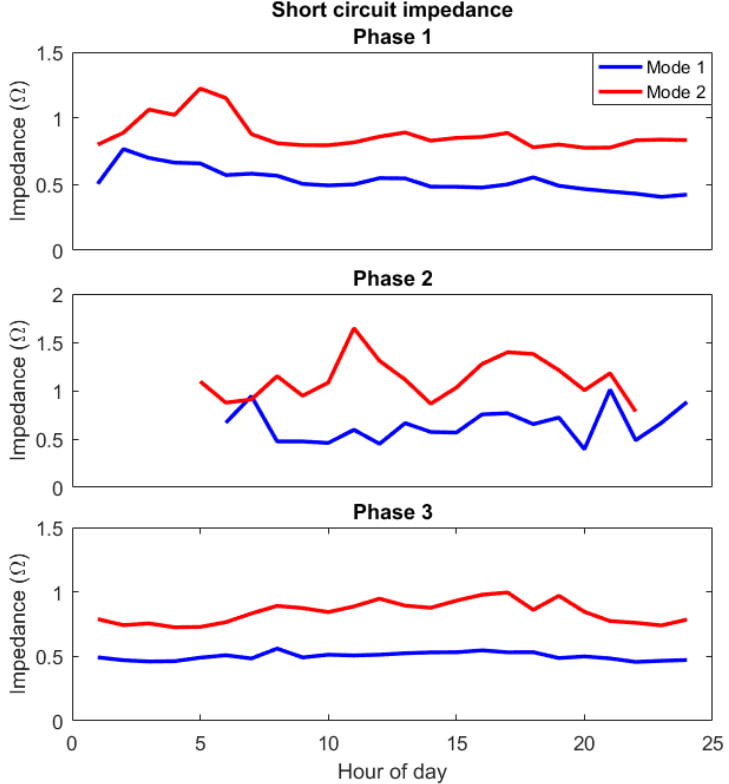
Figure 17. The average short circuit impedance for each hour of the day for around 8 weeks in islanded operation for Mode 1 and Mode 2 seen in Figure 13.